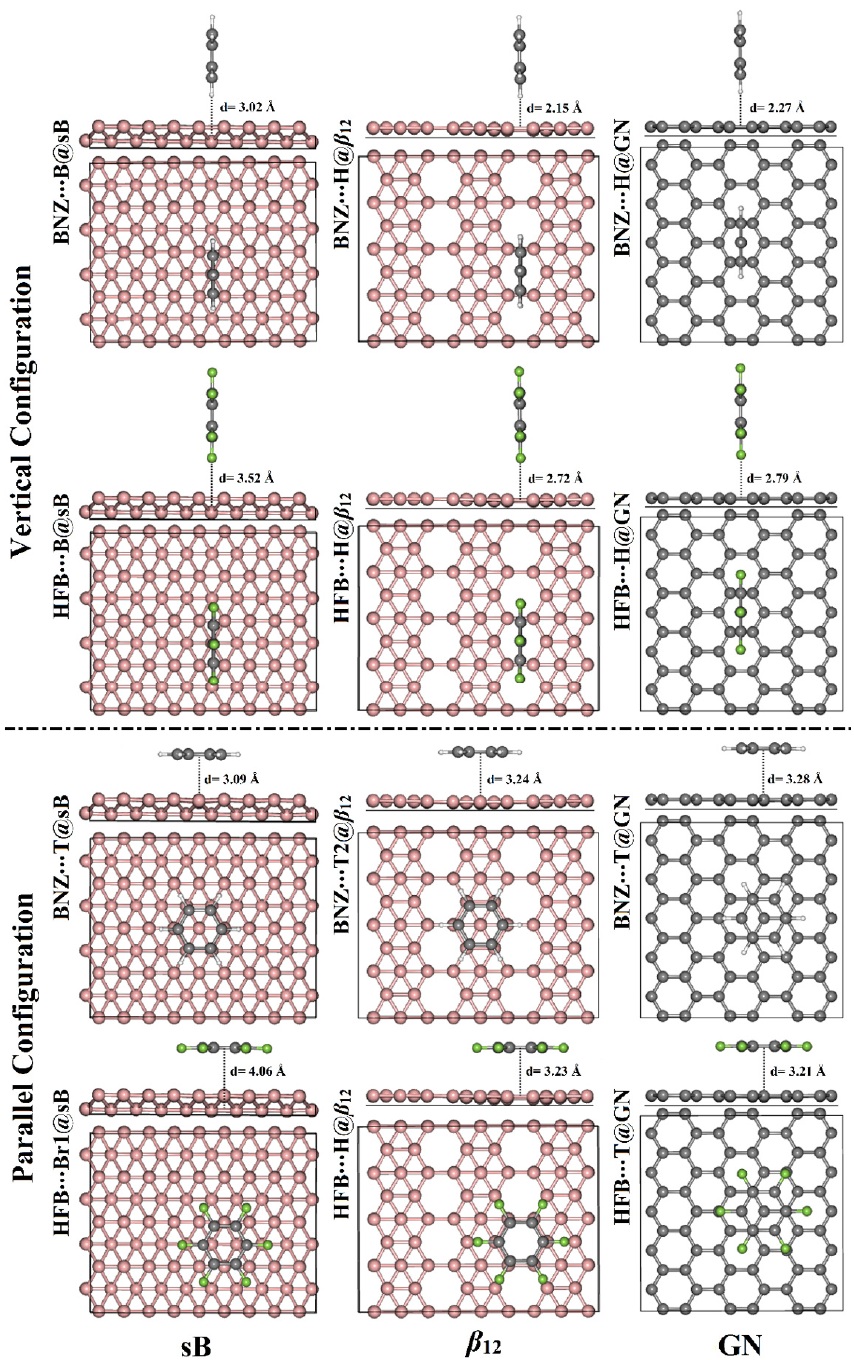
Figure 3. Side and top views of the relaxed structures of the vertical and parallel configurations of the π -system ··· 2D sheet complexes where π -system = BNZ/HFB and the 2D sheet = sB/ β 12 /GN at the most energetically favorable adsorption sites. The π -system–2D sheet equilibrium distances (d) are given in